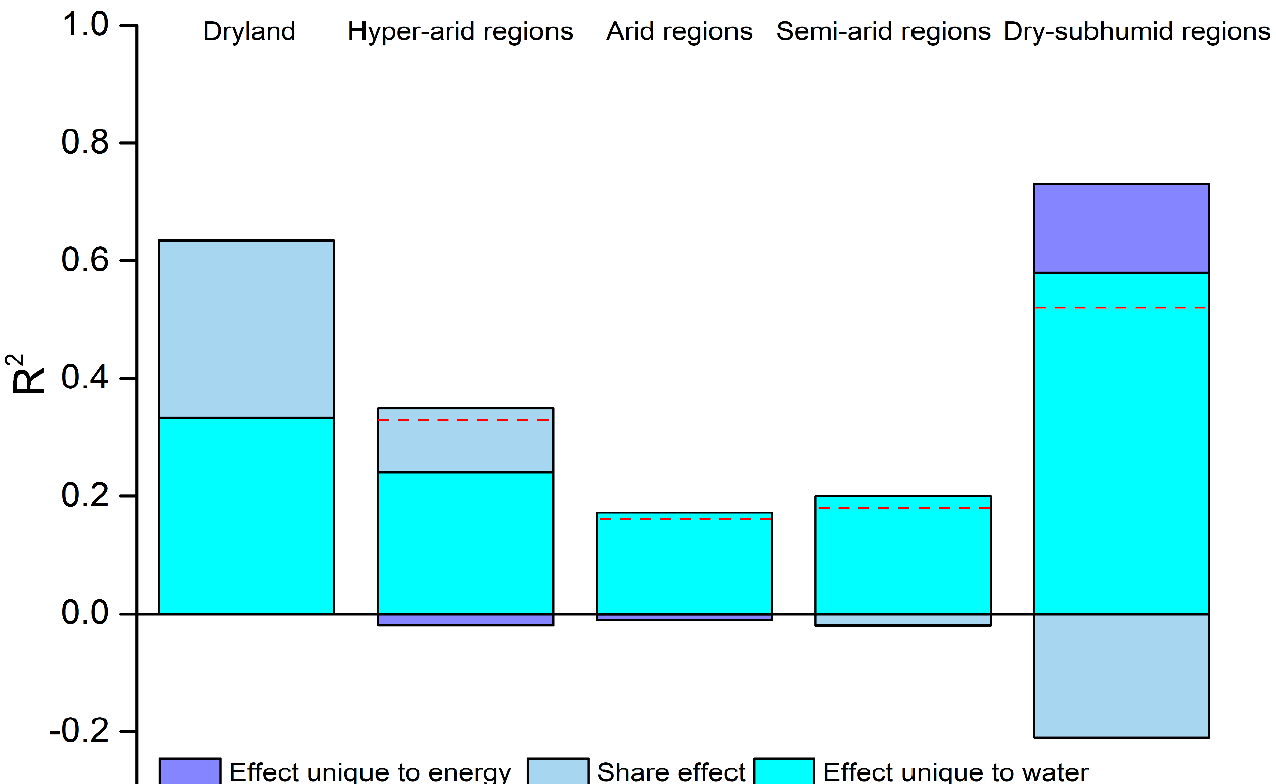
Figure 4. The variation of water and energy effects on overall plant diversity in China’s dryland by variation partitioning. Effect unique to energy is the explained variability by the independent components of environmental energy. Share effect represents variability explained by the covarying component of water and energy. Effect unique to water is the explained variability by the independent components of water. Negative effects indicate that explained variation on plant diversity is lowered by the energy unique effect or the interaction between water and energy in different aridity regions, and the red dashed line expresses the actual total variation explained by water and energy in different aridity regions. Plant diversity is expressed as the number of species in 900 m 2 in each site and is square-rooted in models. R 2 is the adjusted coefficient of determination. Dryland: n = 184 sites; hyperarid regions: n = 26 sites; arid regions: n = 91 sites; semiarid regions: n = 50 sites; dry-subhumid regions: n = 17 sites.